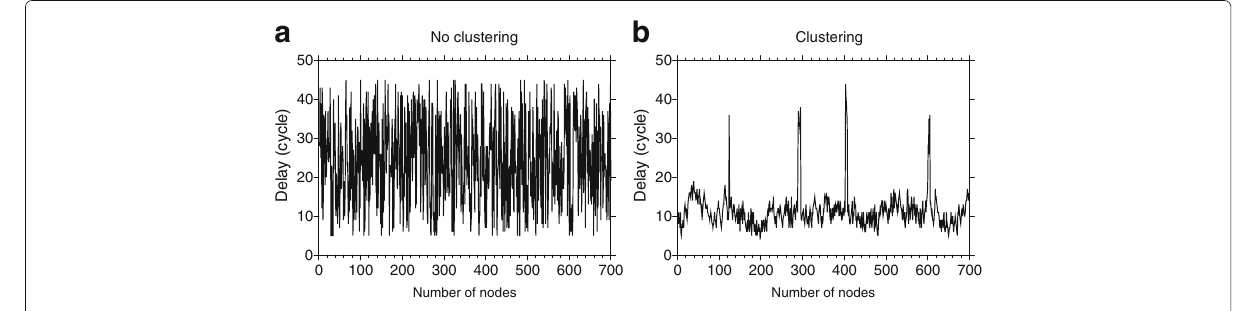
Fig. 13 Latency when no clustering is imposed. a No clustering. b Clustering